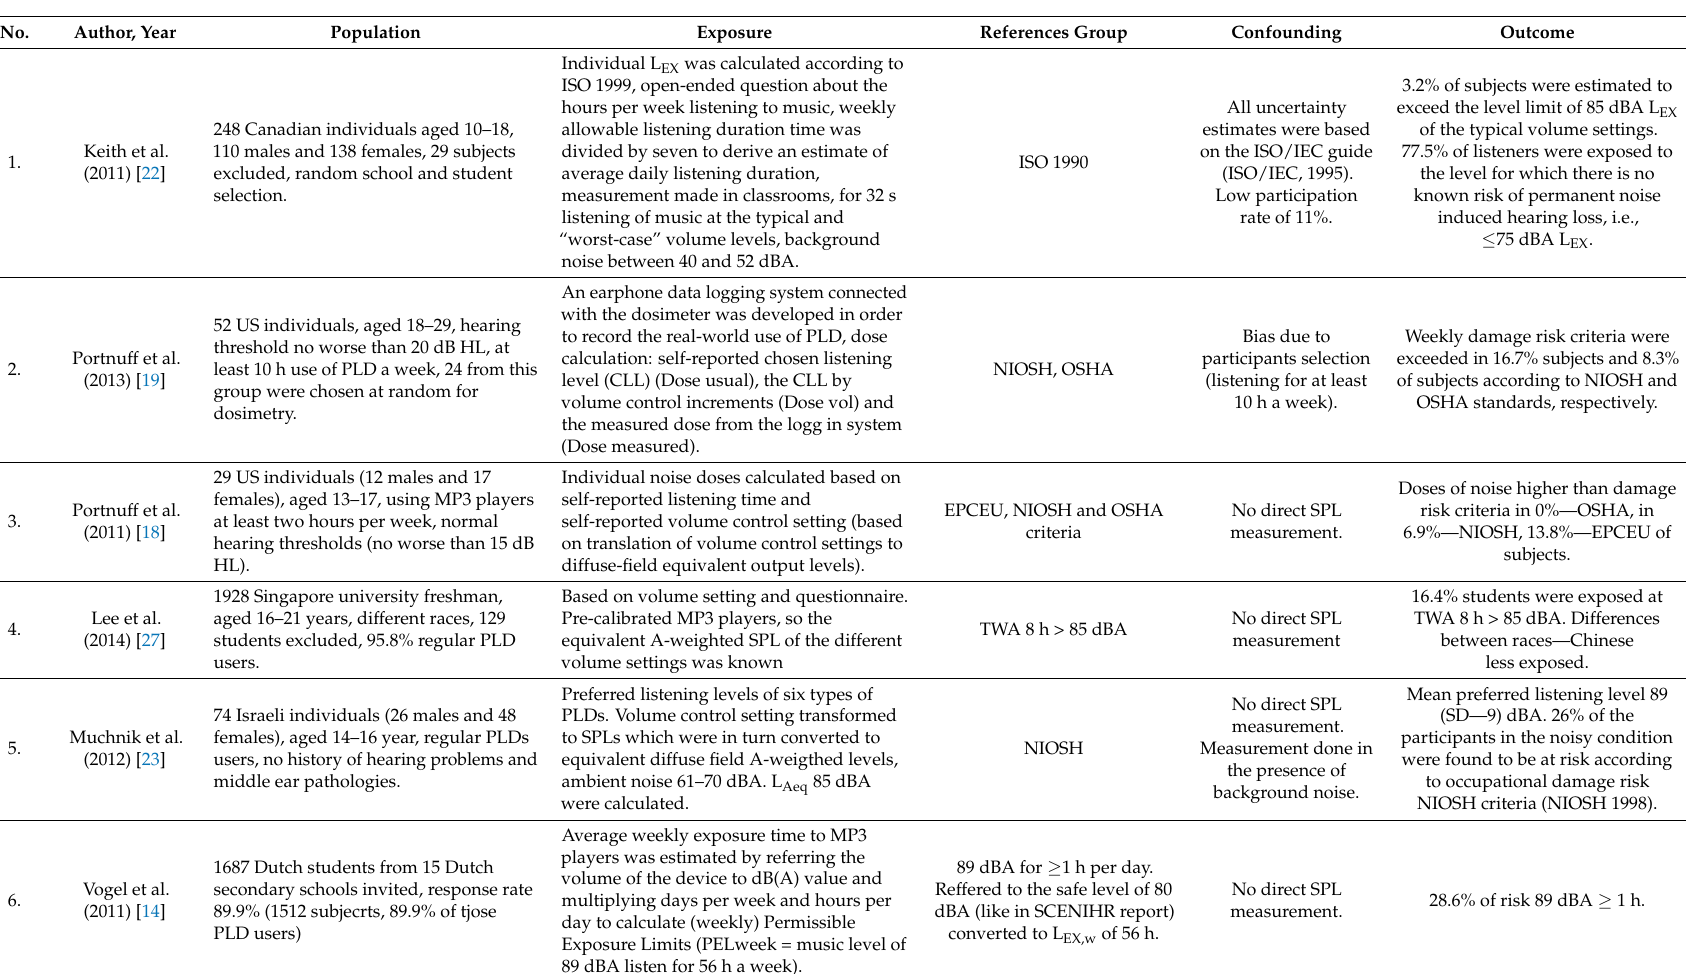
Table 2. Risk of permanent hearing loss due to the use of Personal Listening Devices (studies published after